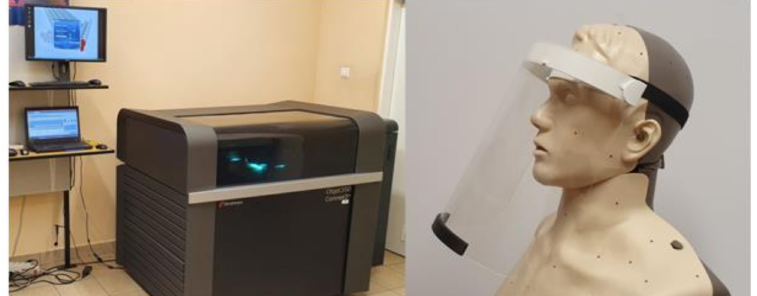
Figure 2. Possible application of MJ technology (PolyJet) for the manufacture of protective visor